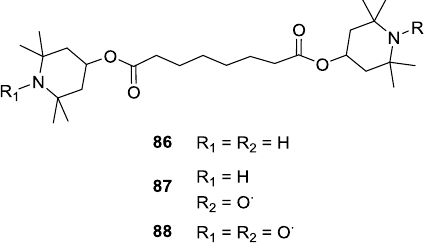
Figure 10. Structure of the Tinuvin 770 ( 86 ) and its oxidation